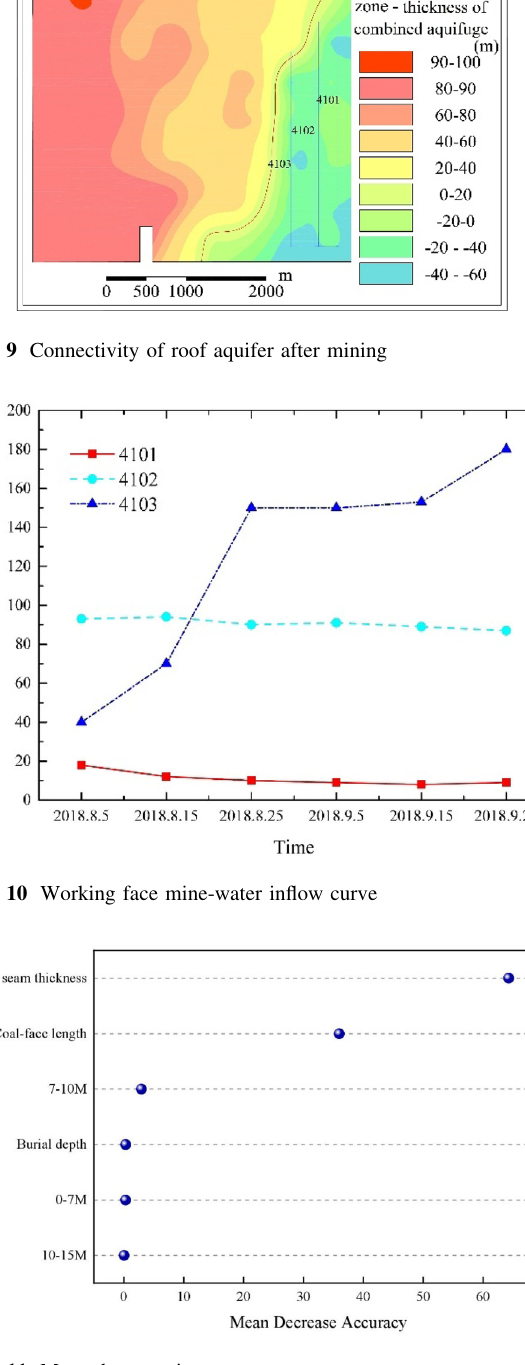
Fig. 11 Mean decrease in Among the variables, the most important is coal seam thickness, followed by working face length, and the ratio coefficient of hard rock proportion in